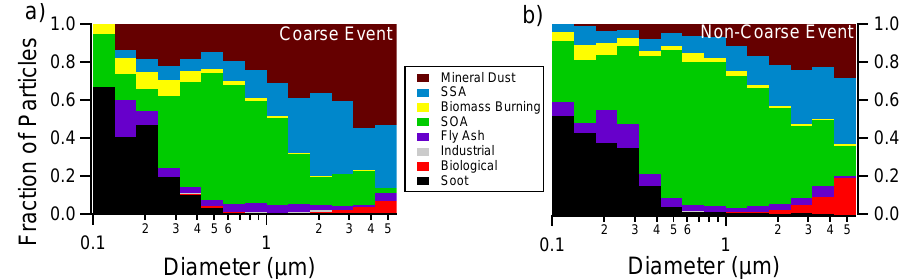
Figure 5. Compositional analysis using SEM with EDX of particles collected during the SOAS campaign as a function of particle diameter during (a) the two coarse particle events and (b) throughout the remainder of the field campaign. SSA indicates sea spray aerosol and SOA indicates secondary organic aerosol.